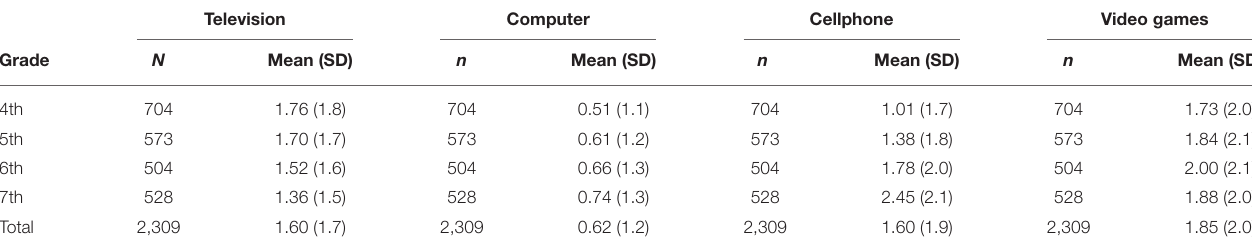
TABLE 3A | Average hours spent using technological devices every day of weekends by grade ( n = 2,309; Missing data =